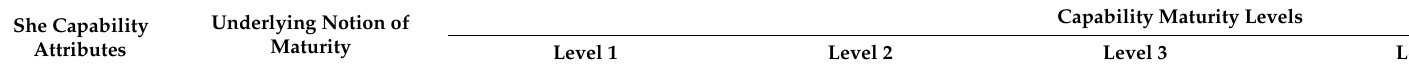
Table 3. The iSHEM-CMM